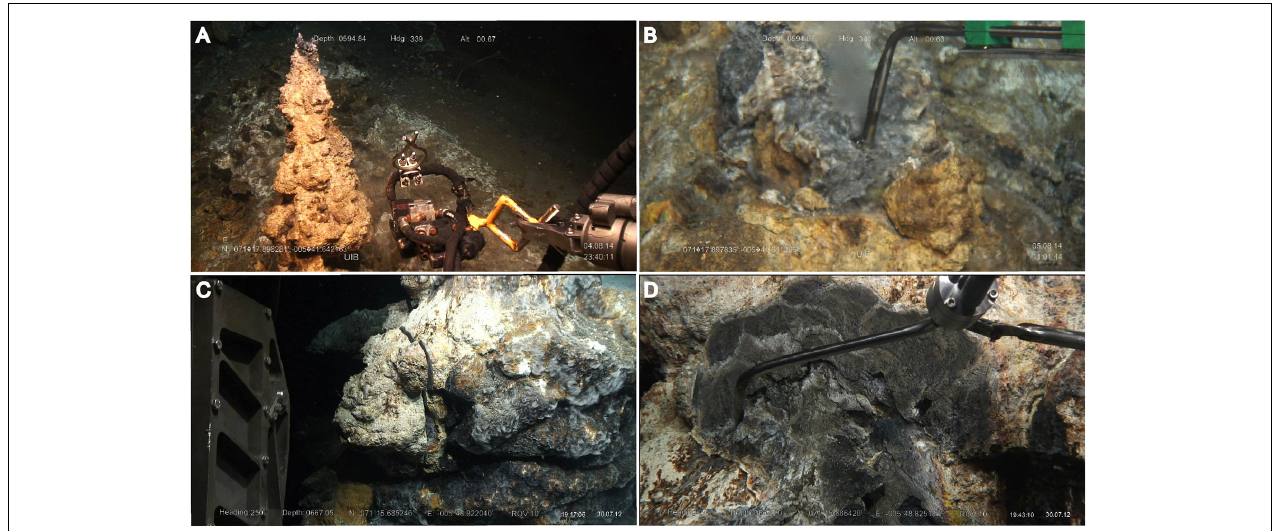
FIGURE 1 | Sampling of chimneys and hydrothermal fluids. (A) The Bruse chimney before sampling. (B) Collection of hydrothermal fluids emitting through the central flow channel of the Bruse chimney after cutting with a chainsaw. (C) Sampling of the Soria Moria chimney using a chainsaw. (D) Collection of hydrothermal fluids emitted through a fracture in the cross section created during sampling of the Soria Moria chimney